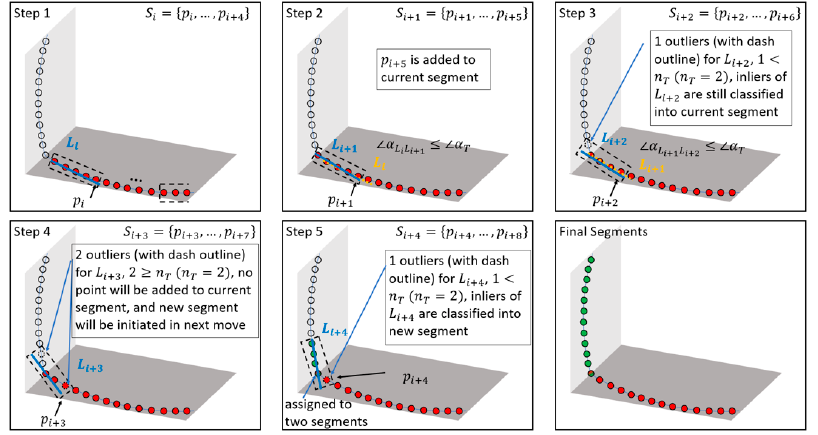
Figure 9. Illustration of the proposed SLS strategy with points pertaining to two smooth curve segments. A set of sequentially scanned points is assumed to consist of five points and the outlier threshold n T is set to 2.